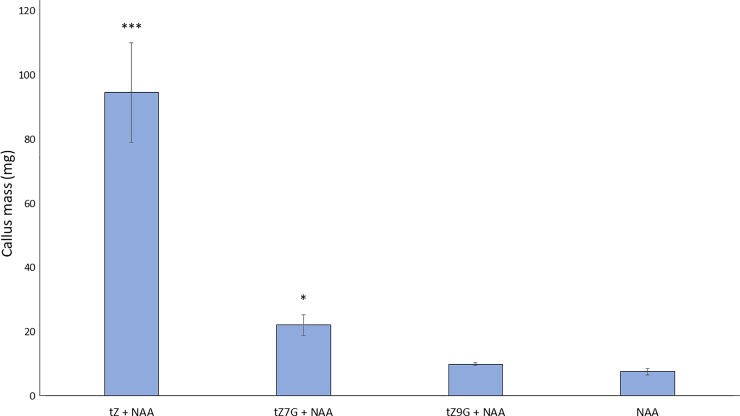
Trans-Zeatin-7-glucoside mildly promotes shoot initiation.Hypocotyls from etiolated Arabidopsis seedlings were transferred to MS + 1% sucrose supplemented with equimolar amounts of NAA and the indicated cytokinins. The negative controls were supplemented with an equal volume of DMSO in lieu of cytokinin. After 45 days, callus weight was measured. Average ± SE of three biological replicates is shown (n ≥ 4 per treatment per replicate). *** p-value < 0.001, * p-value < 0.05, Student’s two-tailed t test.